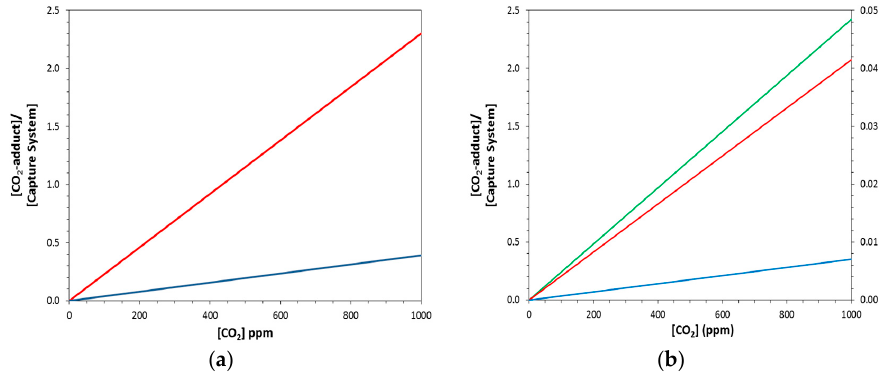
Figure 4. Carbon capture at 298.15 K for two carbon capture systems at near atmospheric concentrations. Gibbs free enthalpies of Δ G ° = − 5.54 kcal/mol (R14b, blue ), Δ G ° = − 6.59 kcal/mol (R14a, red ), and Δ G ° = − 9.00 kcal/mol (R14h, green ). Plots for GCR are shown in ( a ) and plots for the RCR are shown in ( b ). To achieve a significant capture ratio in the RCR system requires a significantly more exergonic capture reaction; i.e., green in ( b ). The secondary axis in ( b ) allows for the recognition of the much diminished capture ratios for the less exergonic reactions (blue and red). The linear functions are as follows: ( a ) Blue; y = 3.91 × 10 -4 x, Red; y = 2.30·× 10 -3 x; ( b ) Blue; y = 7.05 × 10 -6 x, Red; y = 4.15 × 10 -5 x, Green; y = 2.42 × 10 -3 x.